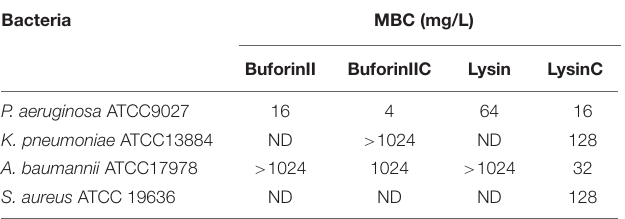
FIGURE 4 | In vivo protection efficacy of partially modified 150-177C peptides in a mouse sepsis model. Two hours post-inoculation, the mice ( n = 10/group) were treated with 5 mg/kg of HBcARD peptides modified with 50 and 100% D -arginine substitutions (D-150-177C, DL-150-177C, and LD-150-177C in Figure 1 ). All of these peptides can successfully protect S. aureus -infected mice from death with a high efficiency (80 –